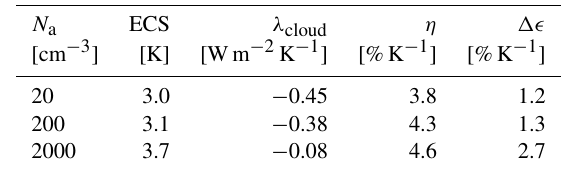
Figure 1. (a) The sea surface temperature (SST) along time for the different simulations conducted under different aerosol and CO 2 concentrations. The shaded grey area is referred to as equilibrium conditions. (b) Change in equilibrium SST due to a change in CO 2 concentration (compared to the 1 × CO 2 case of each aerosol con- centration), for the different aerosol concentrations (the different curves). Table 1. Average equilibrium climate sensitivity (ECS), cloud feed- back parameter ( λ cloud ), hydrological sensitivity ( η ) and change in precipitation efficiency ( (cid:49)(cid:15) ) of the three combinations available for each N a condition (2 × CO 2 − 1 × CO 2 , 4 × CO 2 − 2 × CO 2 and 4 × CO 2 − 1 × CO 2 ). For the calculation of the average ECS, the difference between 4 × CO 2 and 1 × CO 2 is divided by 2. The rest of the quantities are normalized by the SST change between the rel- evant simulations. Please refer to the text for the definitions of these